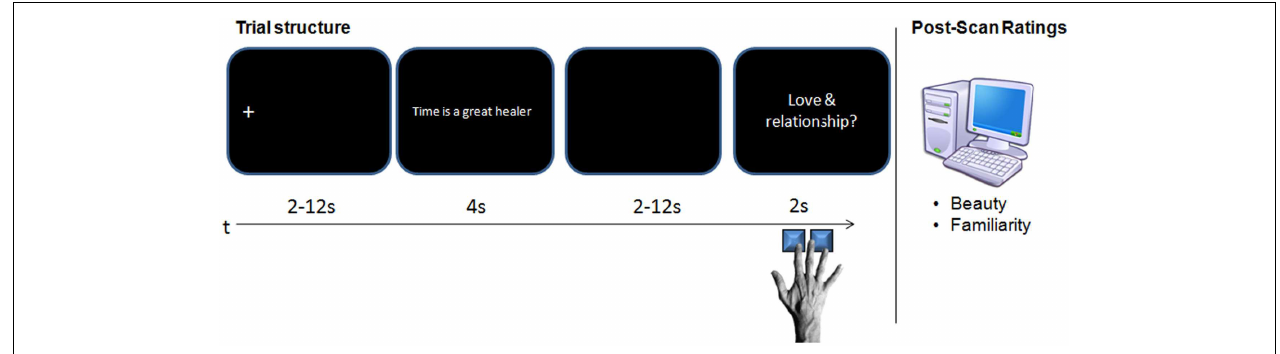
FIGURE 1 |Timeline of one trial in the